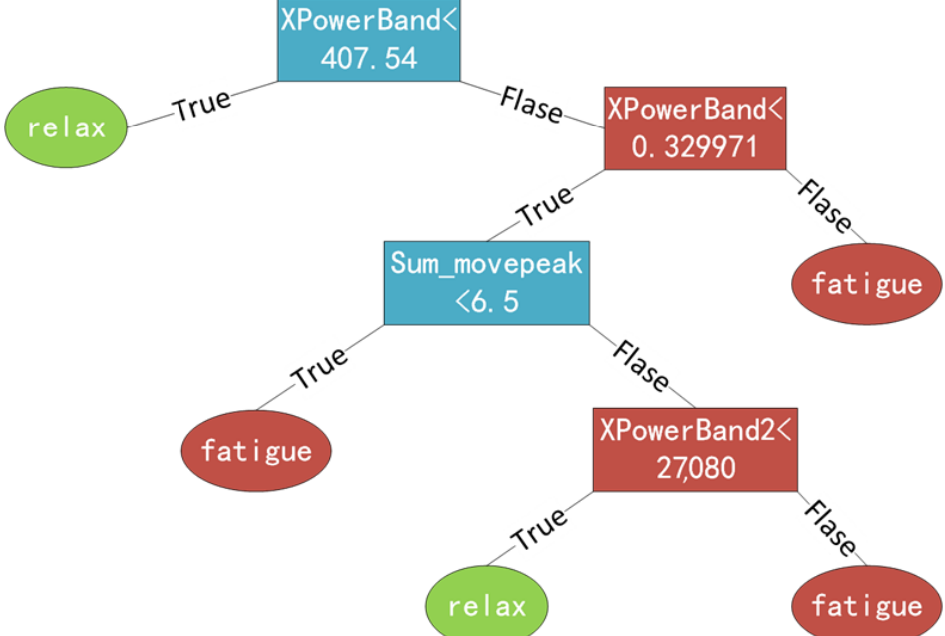
Figure 12. The structure of the pruned classification decision tree.